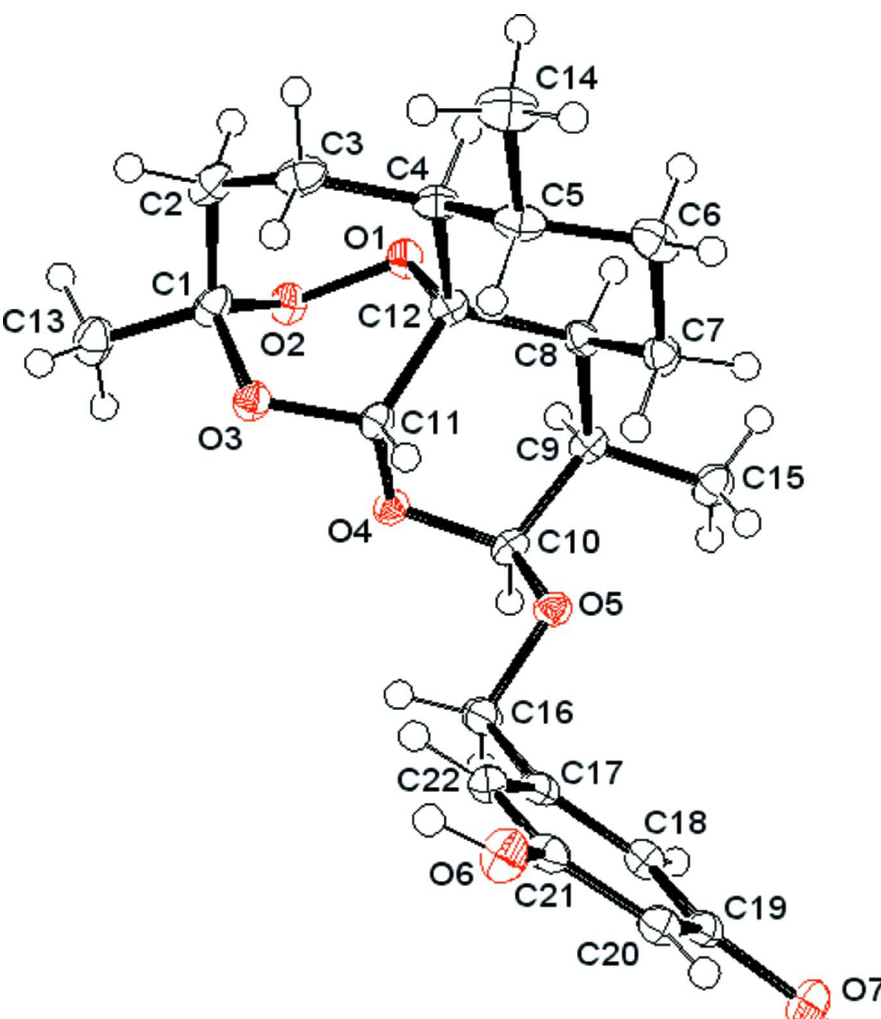
Figure 1 Molecular structure of the title compound with displacement ellipsoids drawn at the 50% probability level for non-H